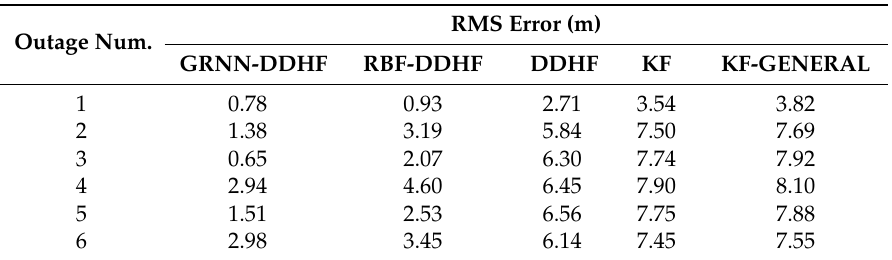
Table 3. RMS position errors during GPS Outages for Trajectory